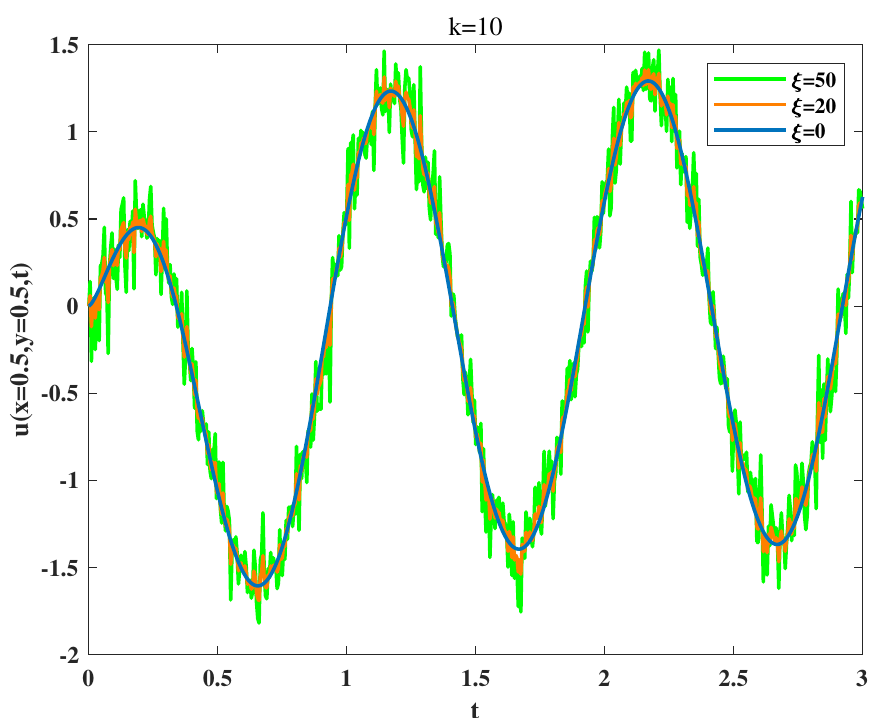
Figure 6. Velocity varies with intensity of noise ξ when k = 10.